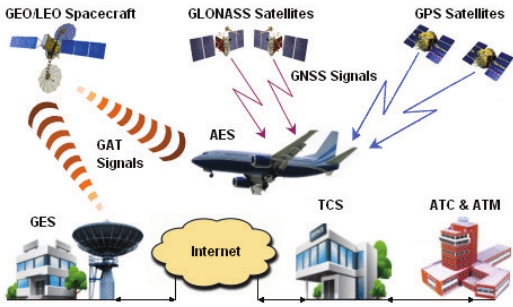
Figure 6. Aeronautical GAT System for GASDL Network – Courtesy of Book: by Ilcev